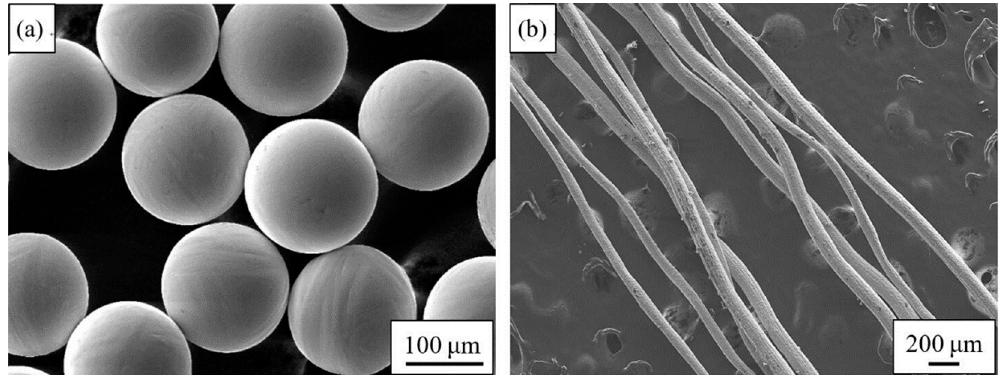
Figure 1. SEM images of the raw materials: ( a ) Ti powder; ( b ) Ti fiber.